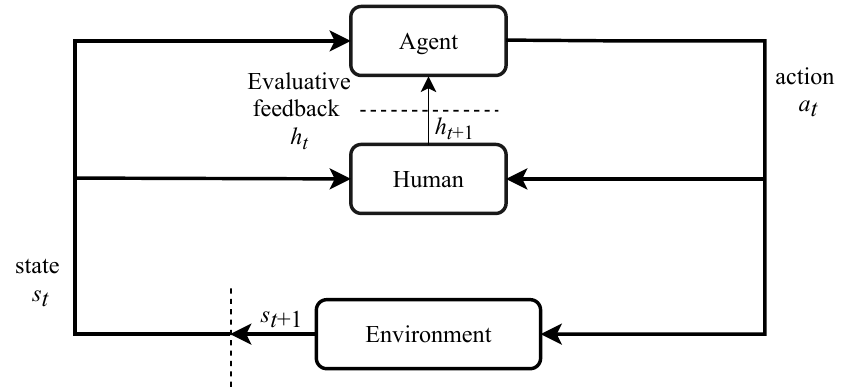
Figure 5. Interaction in Interactive Reinforcement Learning (reproduced from